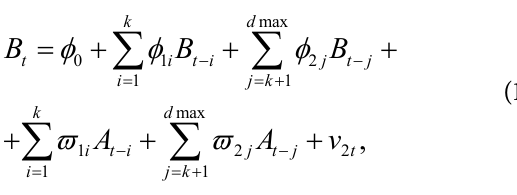
Table 1. Long-run relationship using MGDP as dependent variable